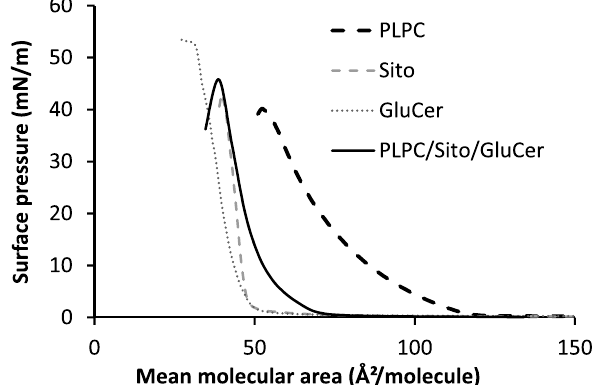
Figure 1. Surface pressure–area (Π–A) compression isotherms, at the air–water interface, of monolayers of pure PLPC, sitosterol (Sito), and glucosylceramide (GluCer), and of their ternary mixture (60/20/20 molar ratio) recorded at 25 °C with a Tris HCl subphase at pH 7.4. Triplicate experiments using independent preparations yielded similar